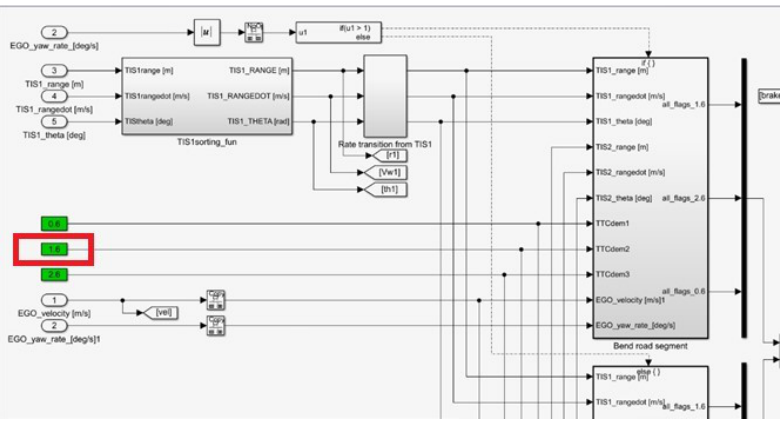
Figure 9. Model of TTC variable that starts partial